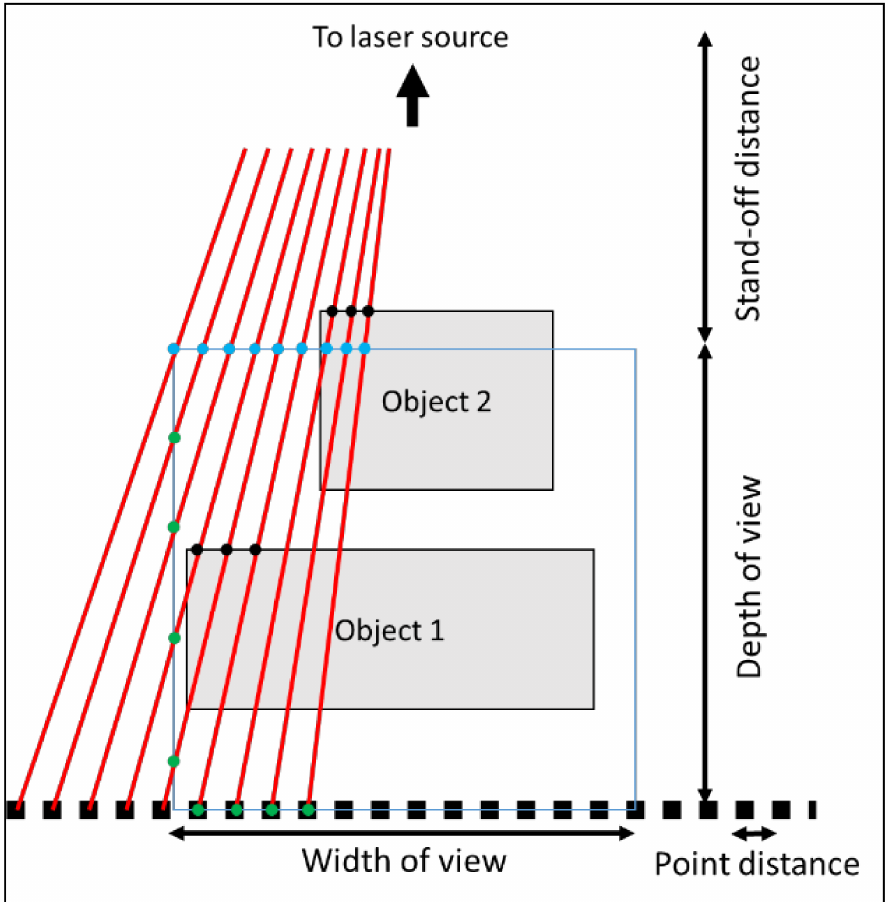
Figure 13. The intersection of the laser beams and the objects in order to determine the mea- sured